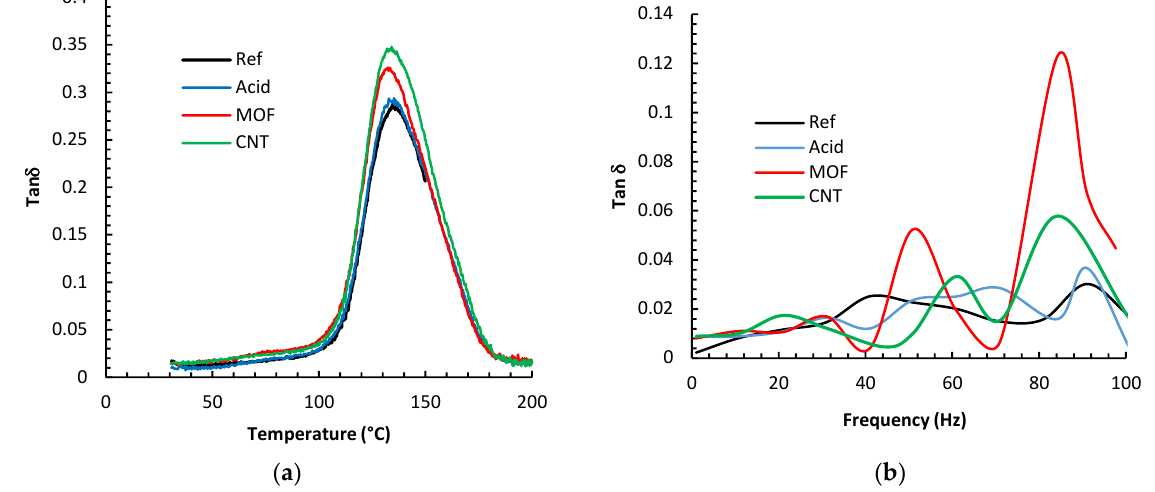
Figure 8. ( a ) DMA measurements of the damping parameter; tan ( δ ) under temperature sweep for the various composites based on different fibers treatments. Measurements were conducted at a 1.0 Hz constant frequency. ( b ) The DMA measurements of the damping parameter for the various composites via frequency ramping at room temperature.